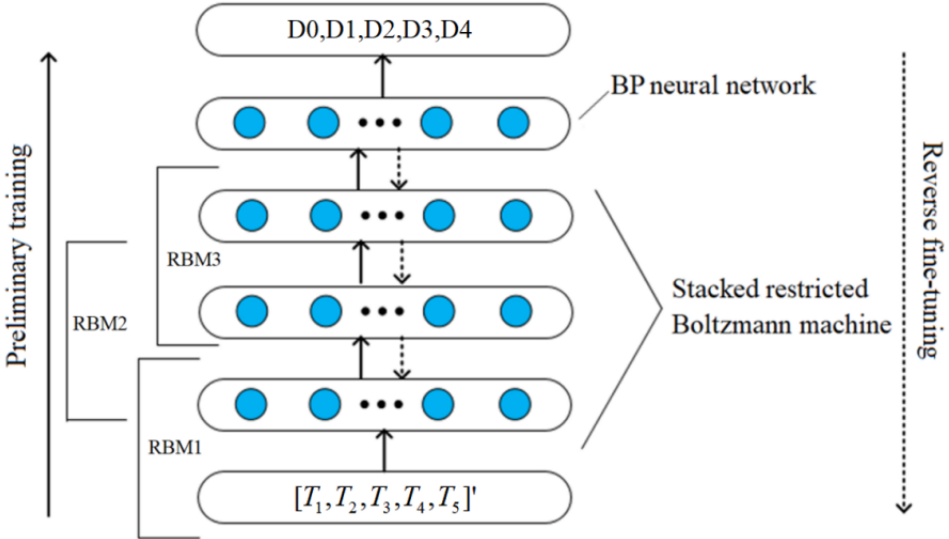
Figure 16. Defect identification model based on deep belief network.